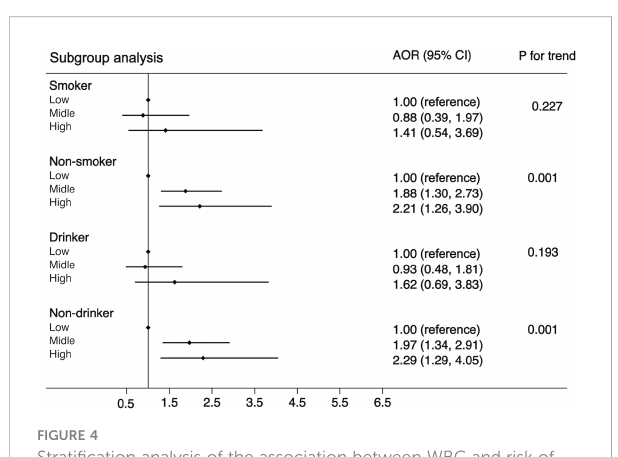
FIGURE 4 Strati fi cation analysis of the association between WBC and risk of MS. Subgroups based on smoking (smoker or non-smoker) or drinking status (drinker or non-drinker). Data are shown as OR and 95% CI.